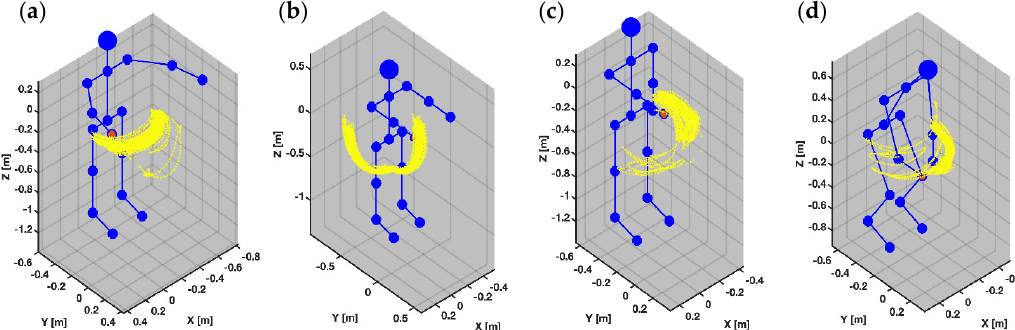
Figure 3. Depicts in blue the action component order for the participant performing the 4 movement tasks during the sensor validation protocol. Illustrated in yellow the OptiTrack reflective marker movement path associated with each movement task. Depicted in blue is a handcrafted skeleton used to establish a spatial reference. From top to bottom, the 4 movement tasks are: ( a ) Horizontal Arm Movement, ( b ) Vertical Arm Movement, ( c ) Rotational Arm Movement, and ( d ) Composite Cross-Body Movement.